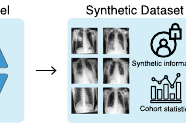
Fig. 1 Synthetic medical imaging dataset generation to overcome data sharing barriers. We train our GAN models with real medical imaging data, to generate the corresponding synthetic images. The synthetic dataset ideally no longer contains private information about individual patients while in aggregate, maintaining the real training cohort ’ s statistical